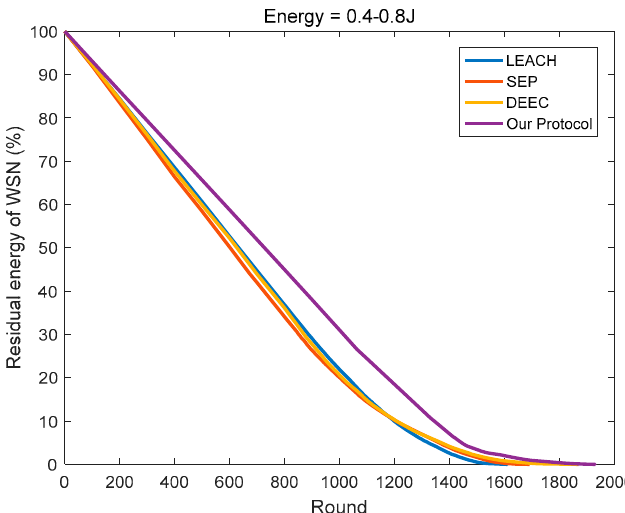
Figure 19. The residual energy varies with the round (the initial energy is evenly distributed at 0.4–0.8 J).